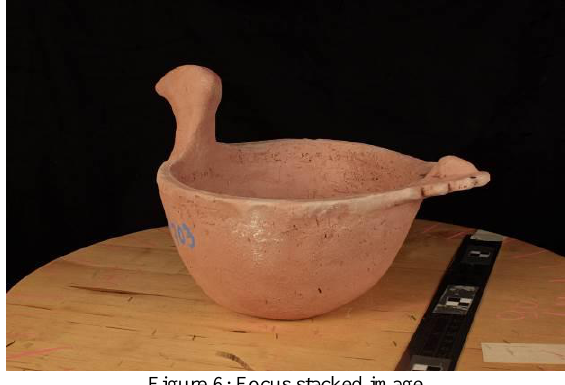
Figure 6: Focus stacked image